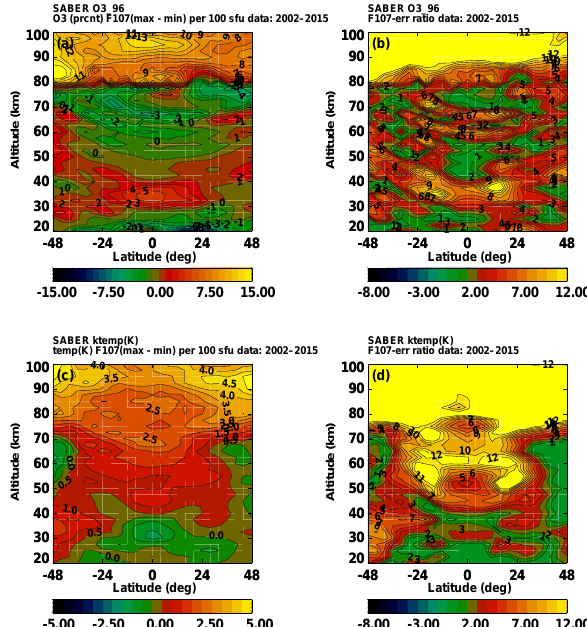
Figure 5. Top row: ozone solar responses (top left) and ratios to their respective uncertainties (top right). Bottom row: as in the top row but for temperatures. The brown colors separate those within 95% confidence (2 σ , red, yellow) from others (green).